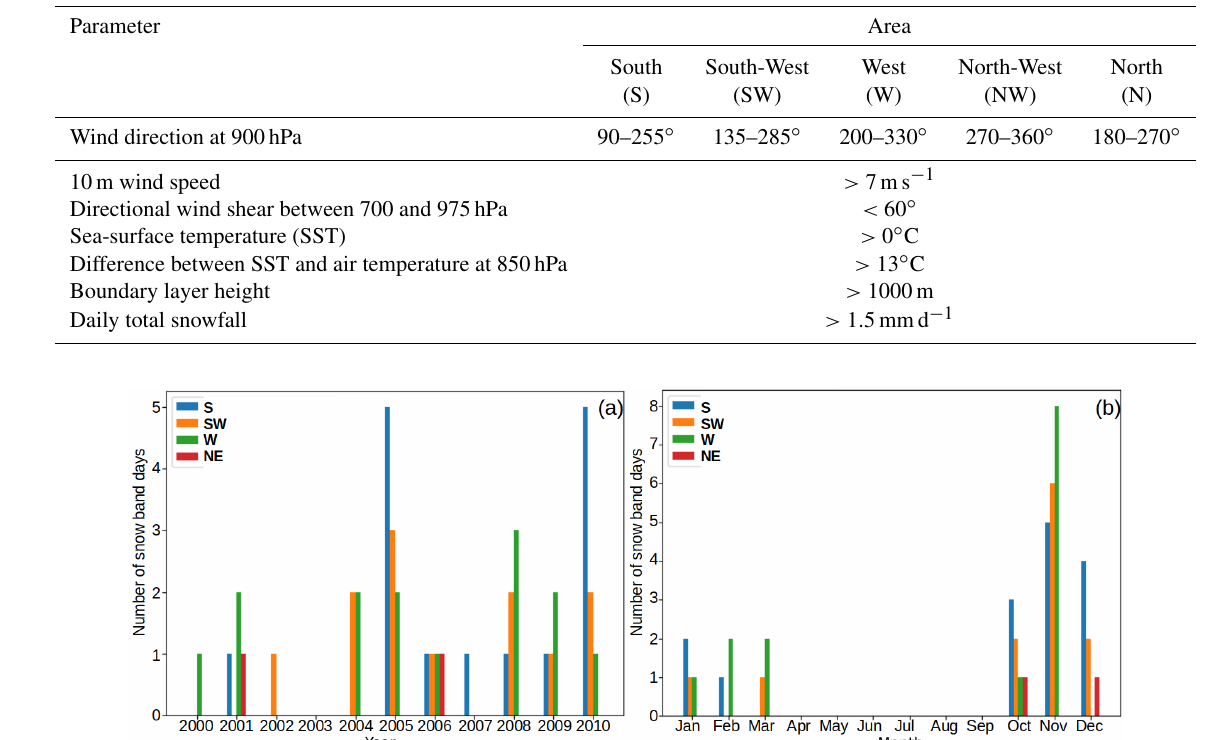
Table 1. Used criteria for the selection of days with favorable atmospheric conditions for convective snowfalls. The areas are defined in Fig. 2.